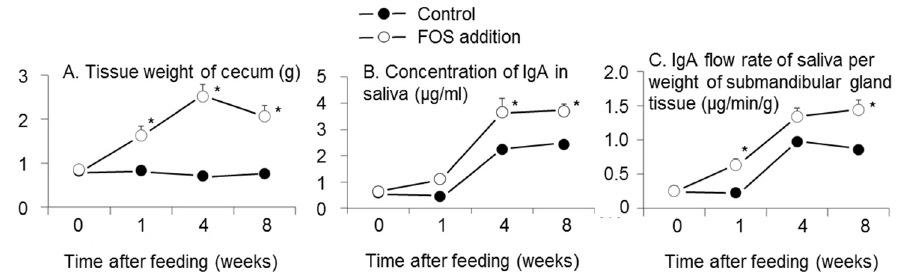
Figure 2. Effects of fructooligosaccharides (FOS) addition and duration of feeding for test diets on the weight of cecal digesta ( A ); pH in cecal digesta ( B ); and IgA concentration in cecal digesta ( C ). n Figure 3. Effects of fructooligosaccharides (FOS) addition and time after feeding on the tissue = 6 per group at each time. Symbols and vertical bars represent means and standard errors, weight of cecum ( A ); concentration of IgA in saliva ( B ); and IgA flow rate in saliva per weight of respectively. There were interactions between FOS addition and intake period in the weight of cecal submandibular gland tissue ( C ). n = 6 per group at each time. Symbols and vertical bars represent contents, pH in cecal digesta, and IgA concentration in cecal digesta ( p = 0.0002, p < 0.0001, and p < means and standard errors, respectively. There were interactions between FOS addition and intake 0.0001, respectively, two way ANOVA). * p < 0.05 versus control group at each week using Tukey’s period in the weight of cecal tissue, concentration of IgA, and IgA flow rate of saliva per weight of multiple comparison. submandibular gland tissue ( p < 0.0001, 0.03, and 0.0009, respectively, two ‐ way ANOVA). * p < 0.05 versus control group at each week using Tukey’s multiple comparison.